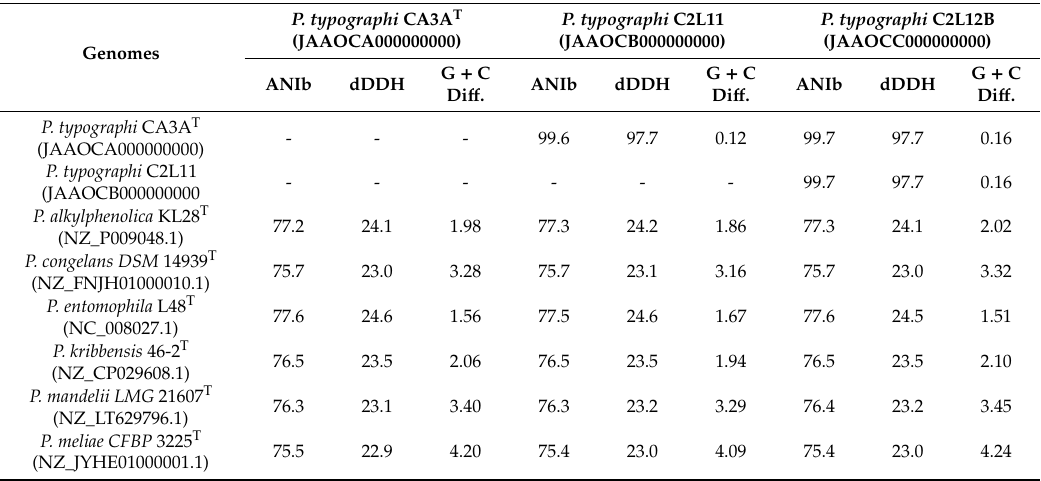
Table 2. ANIb, digital DNA–DNA hybridization (dDDH) (identities/HSP length) and G + C mol% difference, results of comparison of strains CA3A T , C2L11, and C2L12B within them and the closest type strains.